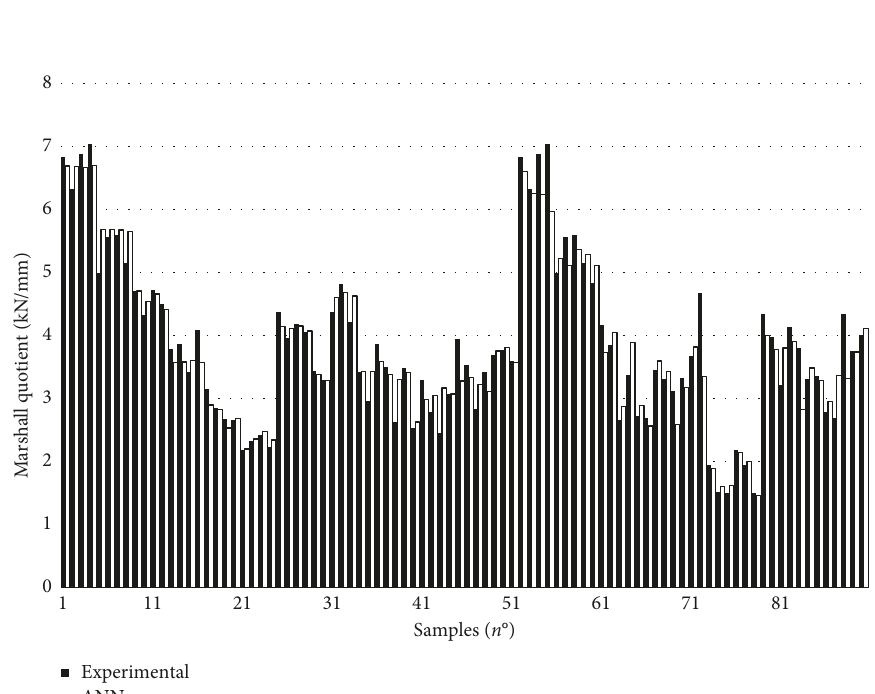
Figure 6: Experimental and ANN-predicted Marshall flow data.